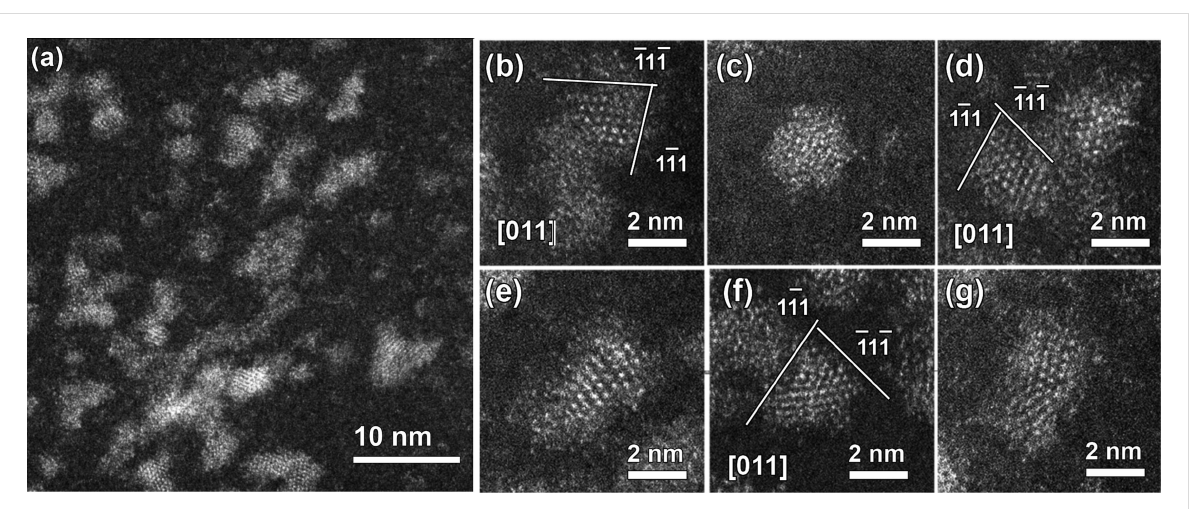
Figure 3: (a) Bright-field low-magnification TEM image of non-doped InP QDs and its number-weighted size distribution (upper insert). Ring electron diffraction pattern (lower insert) confirming zinc blende structure of InP; (b) Number-weighted size distribution of the sample with M nom = 0.5; (c) Number-weighted size distribution of sample with M nom = 1.